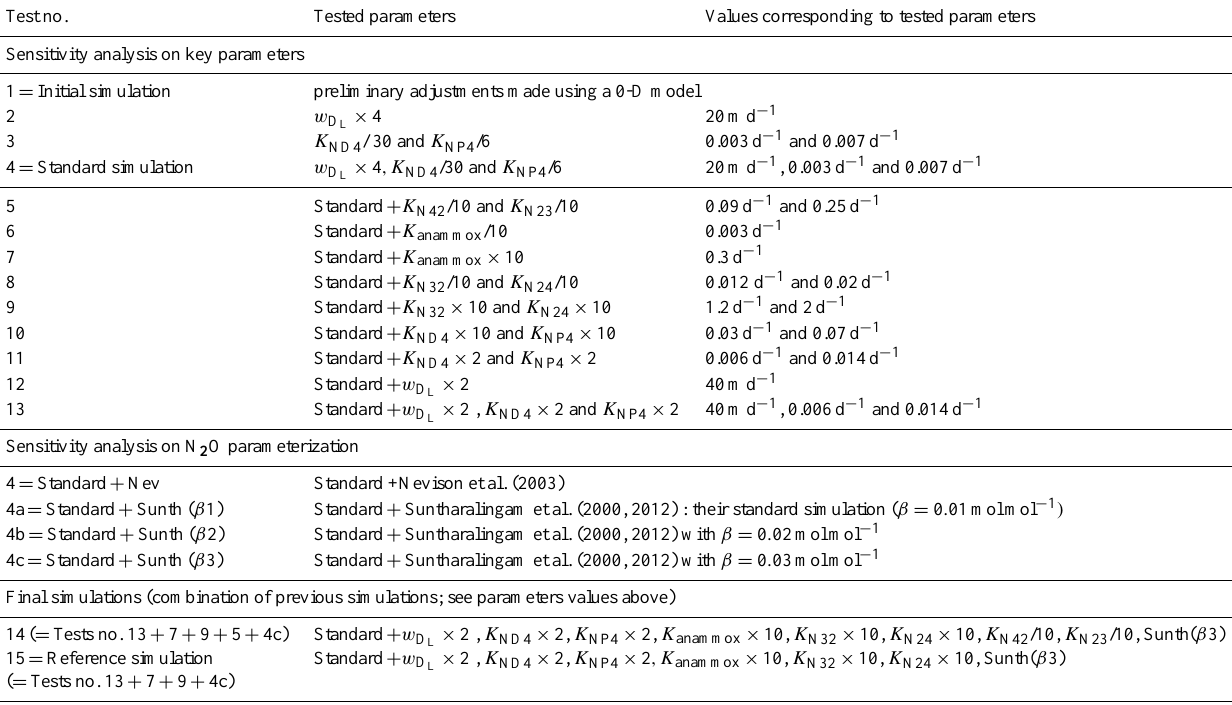
Table 5. Sensitivity analyses: tested parameter values, N 2 O parameterizations, and combined simulations. Test